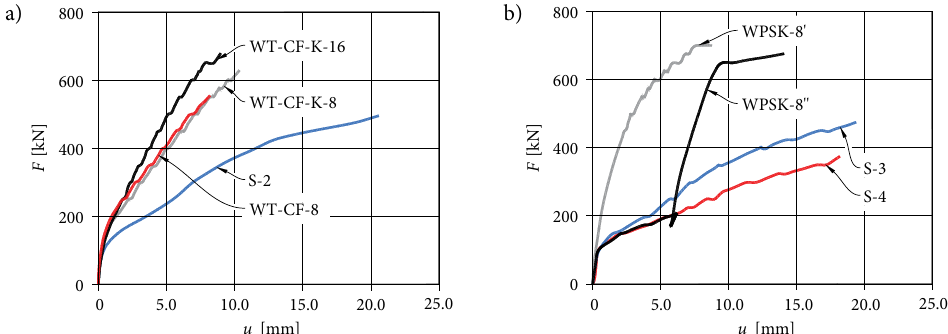
Figure 7. The relationship between load and the deflection of the specimens